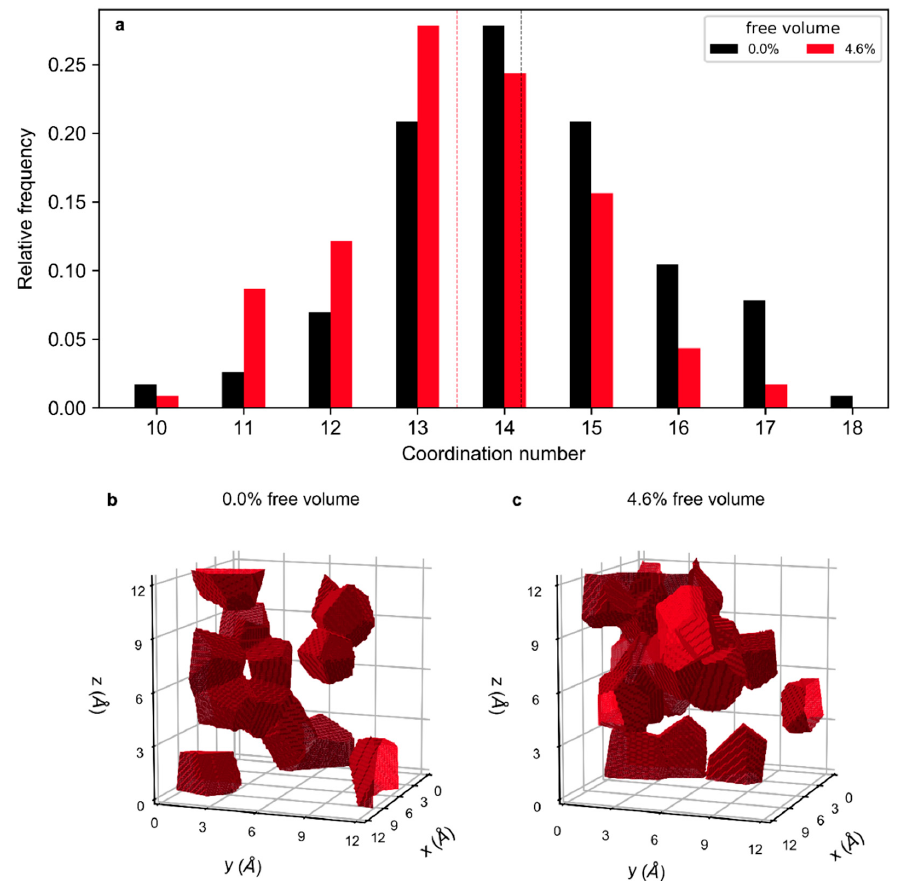
Figure 4. Global and spatially resolved coordination number analysis. ( a ) Relative frequency of occurrence of a coordination number in the sample. Black bars represent the coordination number of a sample with a 0.0% free volume content, and red bars of a sample with a 4.6% free volume content. Dashed lines mark the respective average coordination number. Iso-configuration surfaces enclosing regions with a coordination number of 12 and lower in the simulation cell for a glass with a 0.0% and 4.6% free volume are shown in ( b , c ), respectively.